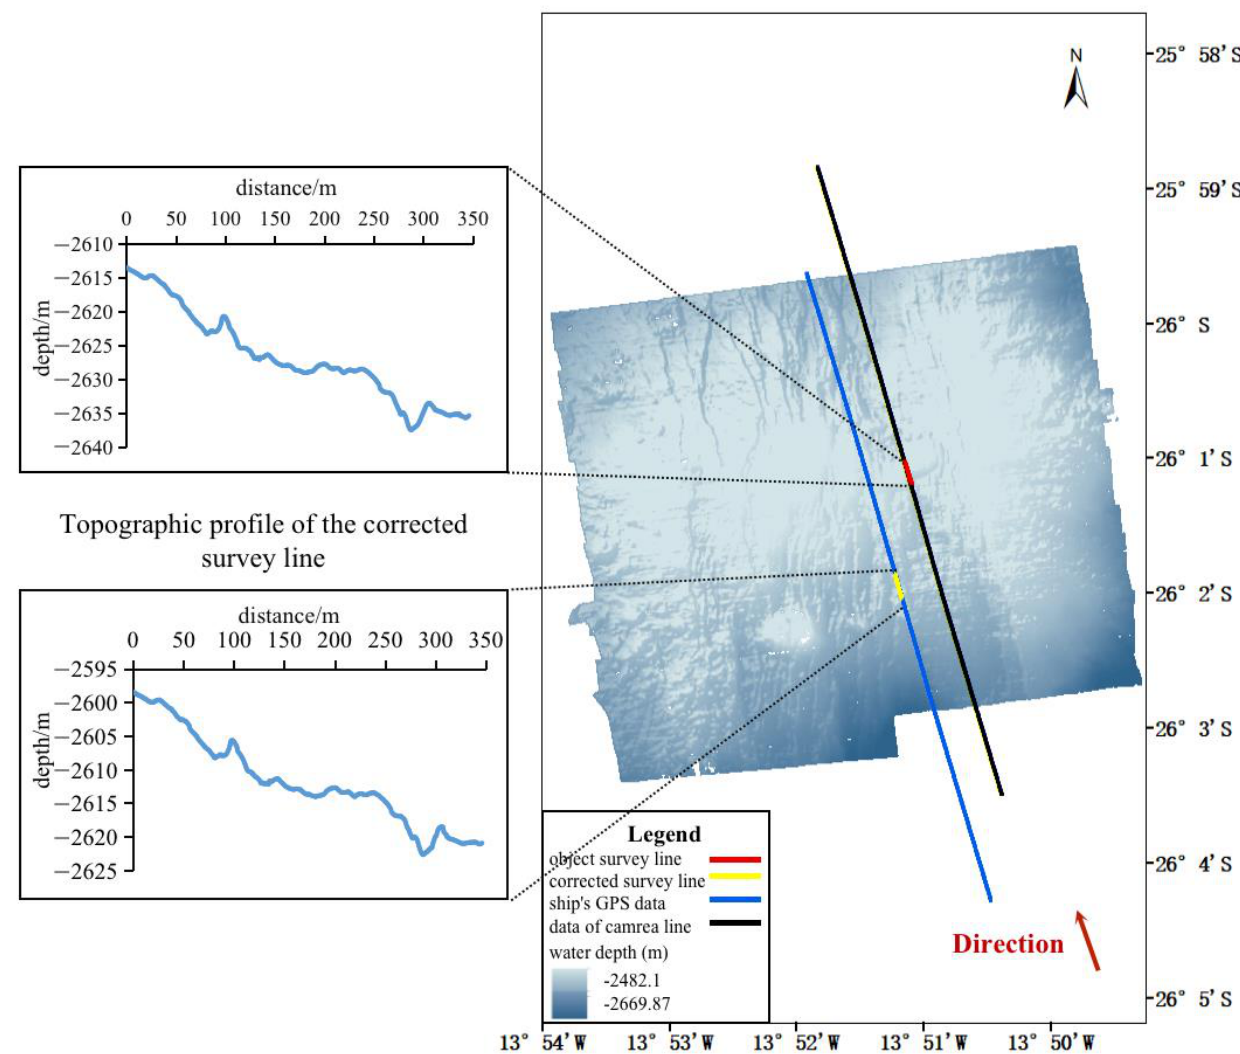
Figure 10. Position of the object survey line after correction.